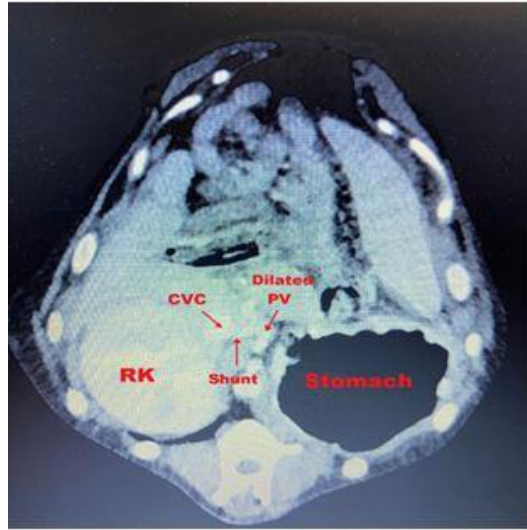
Fig.4: PSS on CT-imaging (RK=Right Kidney, CVC= Cranial Vena Cava, PV= Portal